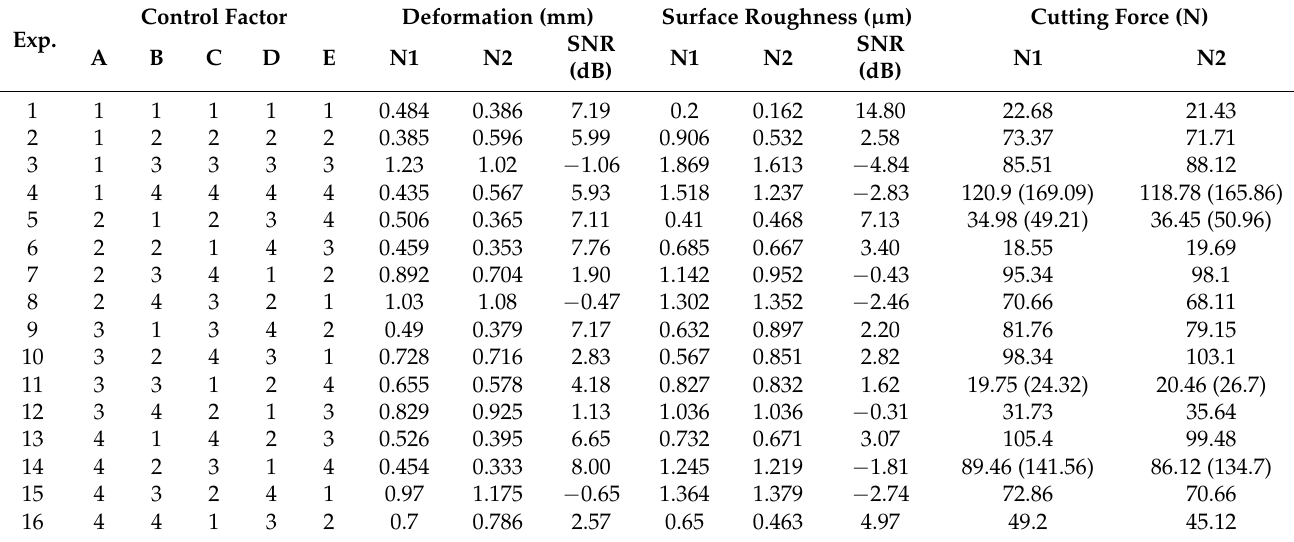
Table 4. Results of L16 orthogonal array for deformation, surface roughness, and cutting force. Control Factor Exp.